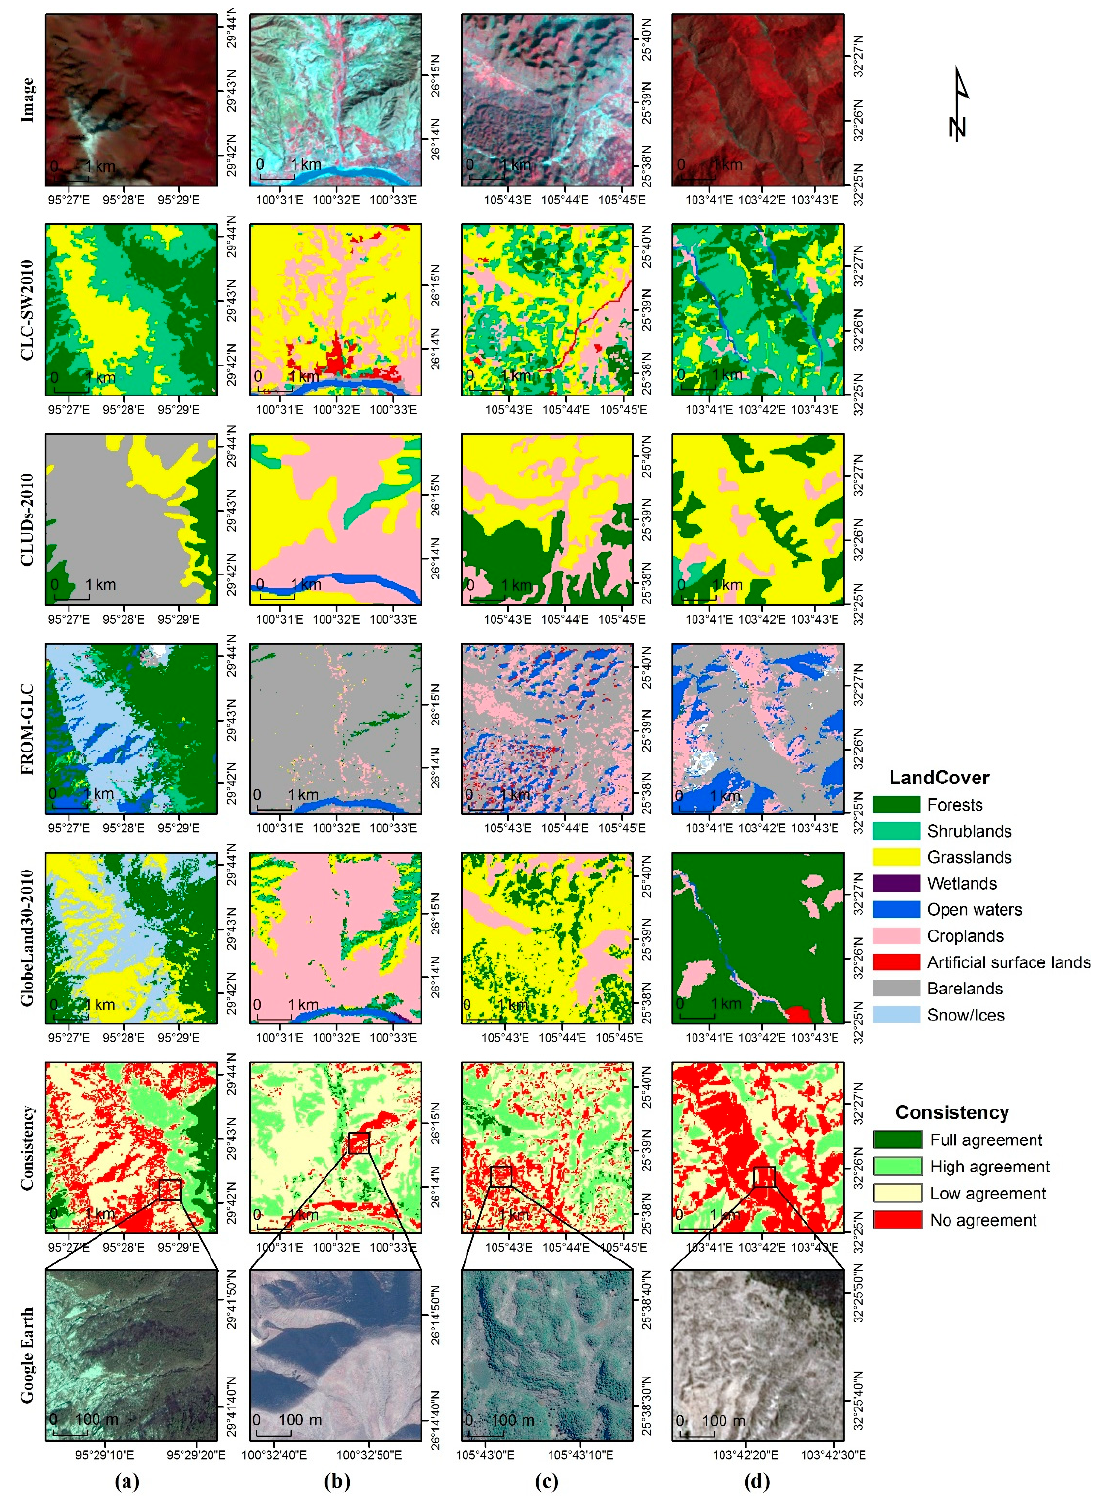
Figure 12. The comparison of classification results among four land cover products in four typical regions. The regions of ( a – d ) are located in Southeast Tibet, the middle part of Yunnan province, the Karst region of Guizhou province and the upper reaches of Minjiang River, respectively. For the consistency of pixels, the full agreement denotes all four products have a same land cover class, high agreement denotes there are two land cover classes among four products, low agreement denotes there are three land cover classes among four products and no agreement denotes there are a unique class in each product.